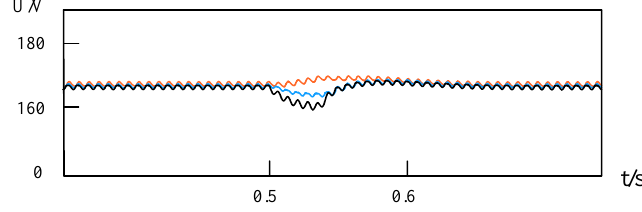
Figure 15. Voltage mutation based on fuzzy PI control.